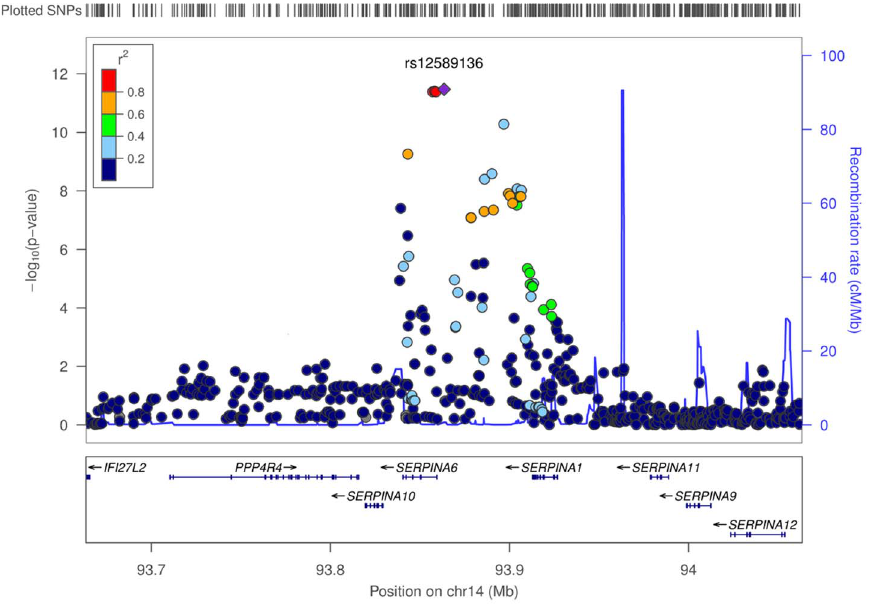
Figure 3. Regional associations surrounding lead SNP rs12589136 in genome-wide meta-analysis of morning plasma cortisol. Regional plot shows 2 log 10 P values of all SNPs, and degree of correlation between all SNPs and lead SNP rs12589136. SNPs with lower P values span SERPINA6 and SERPINA1 genes within a recombination boundary.